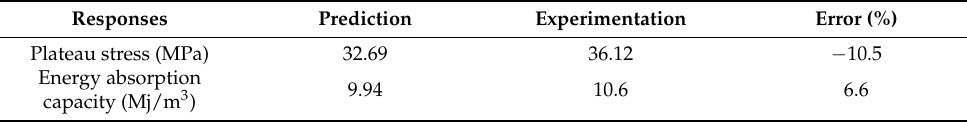
Table 11. Confirmation test comparisons with predicted